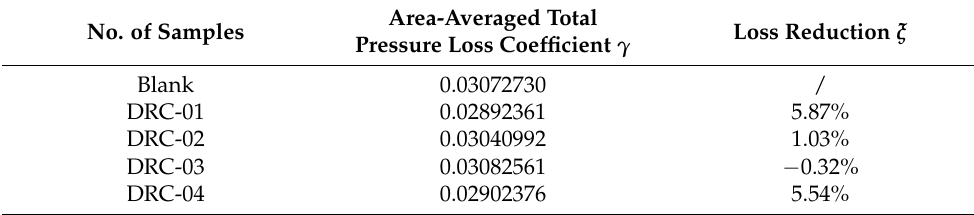
size greatly influence the positive effect of microgroove polyurethane coatings. Table 2. The area-averaged total pressure loss coefficient and percentage of loss reduction. No. of Samples